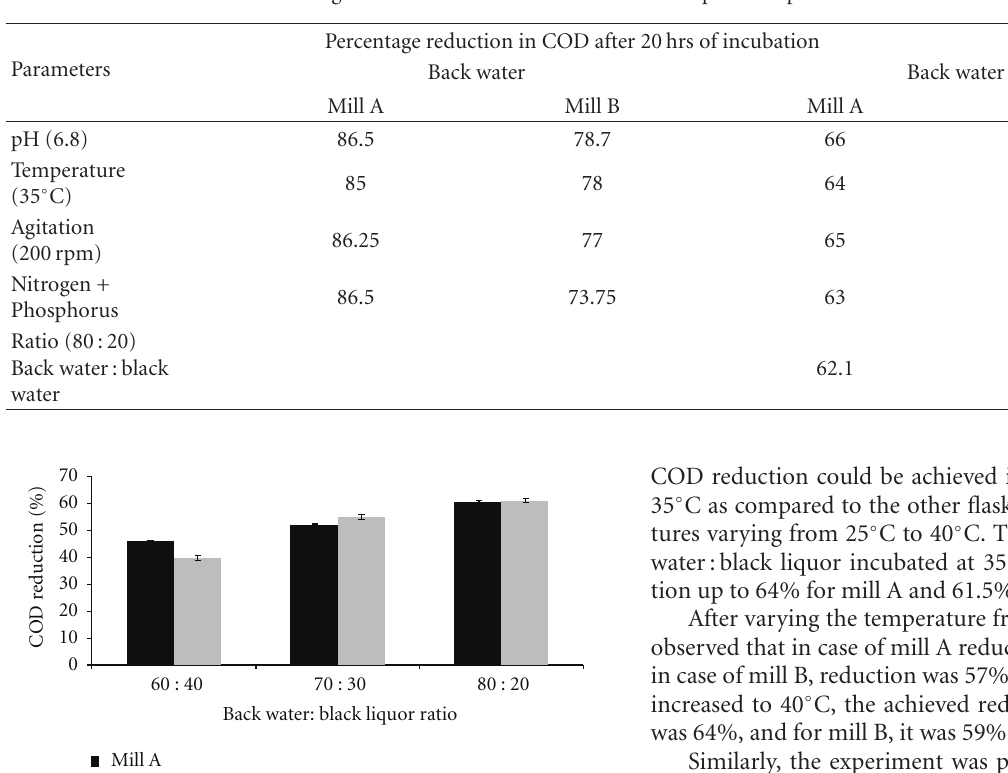
Table 4: Percentage reduction in COD values of di ff erent optimized parameters for Mill A and Mill B.